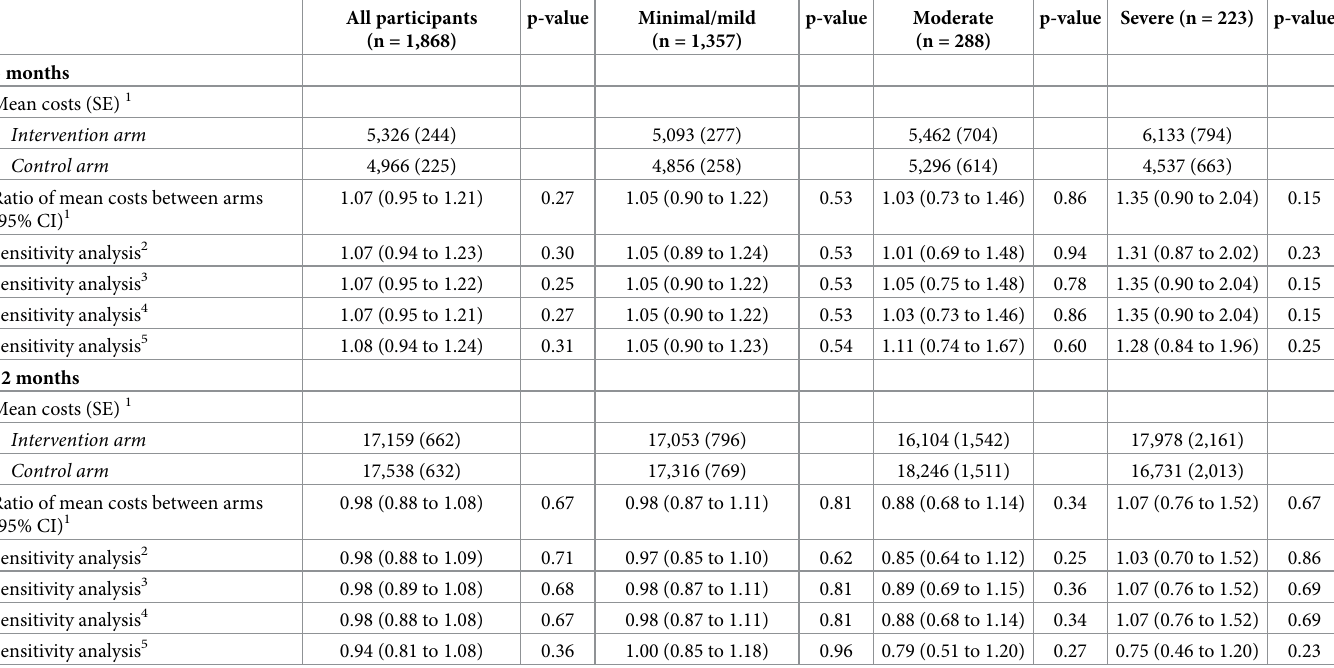
Table 2. Comparison of societal costs by trial arm, across all participants and stratified by prognostic group (multiple imputed data).